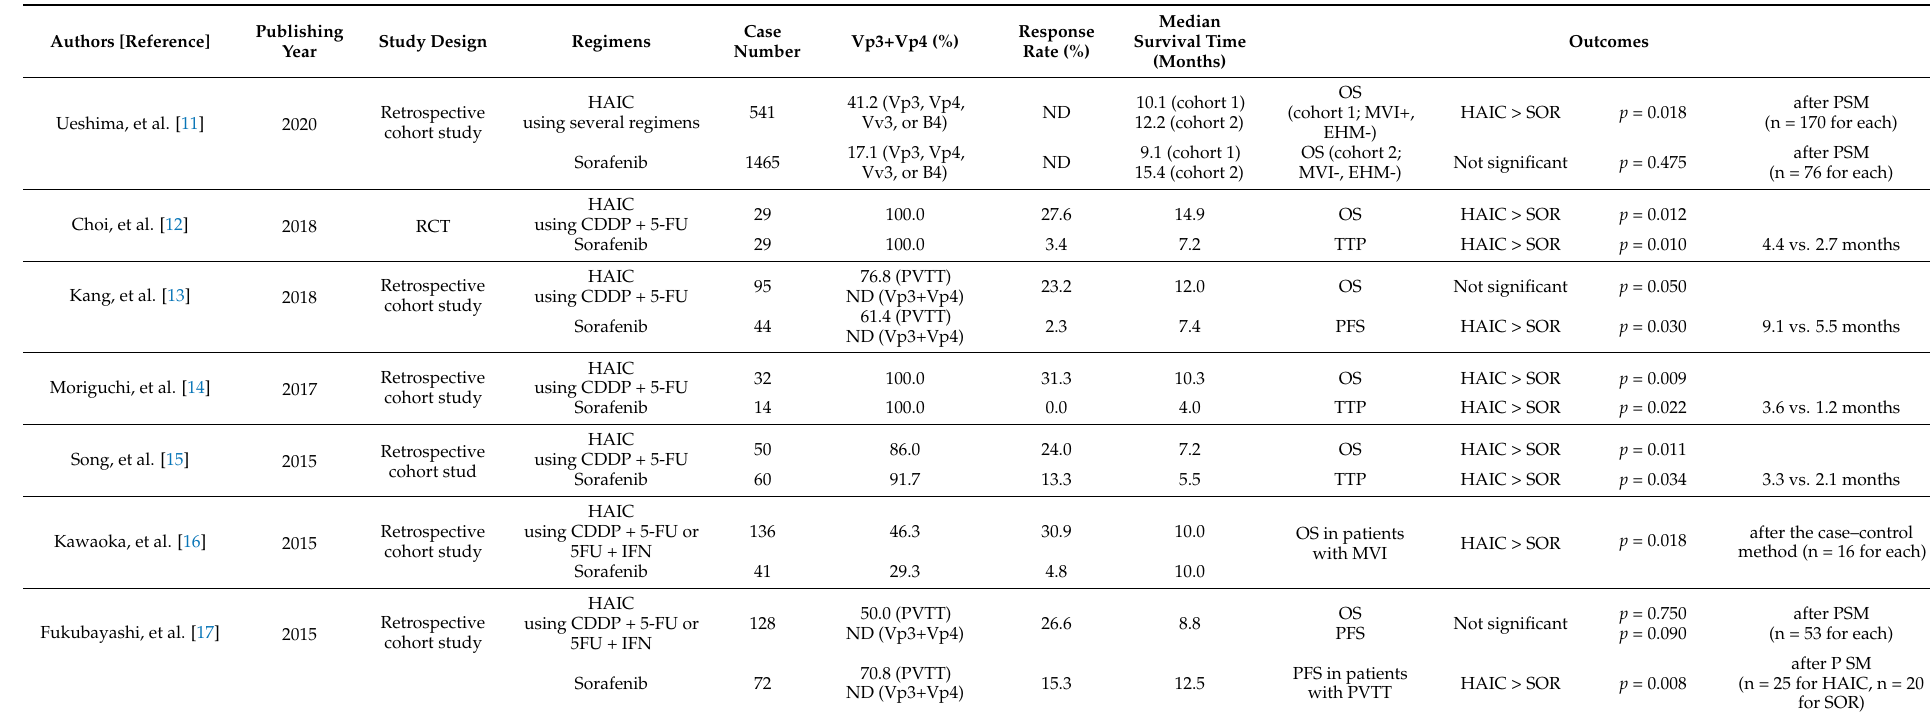
Table 2. Summary of hepatic arterial infusion chemotherapy versus